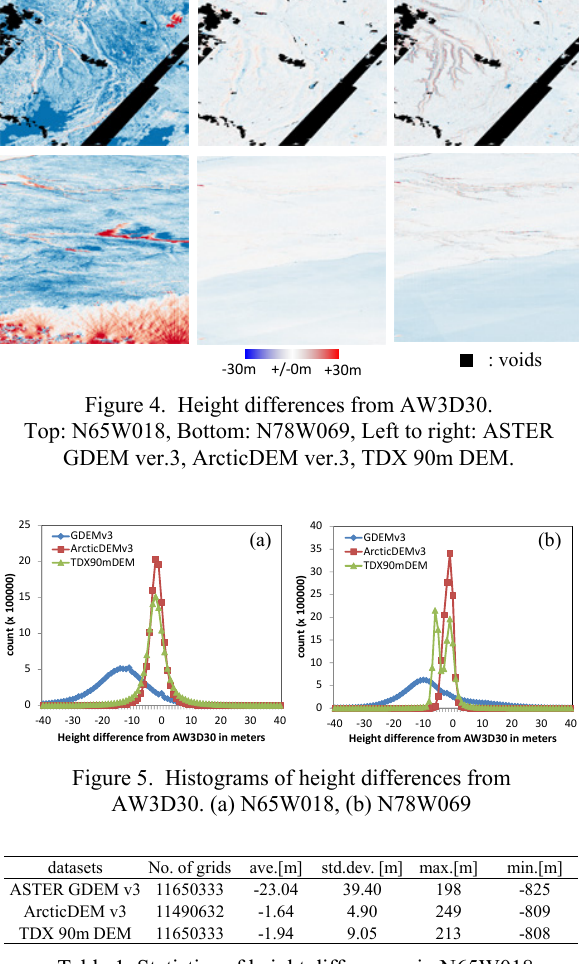
Table 1. Statistics of height differences in N65W018.